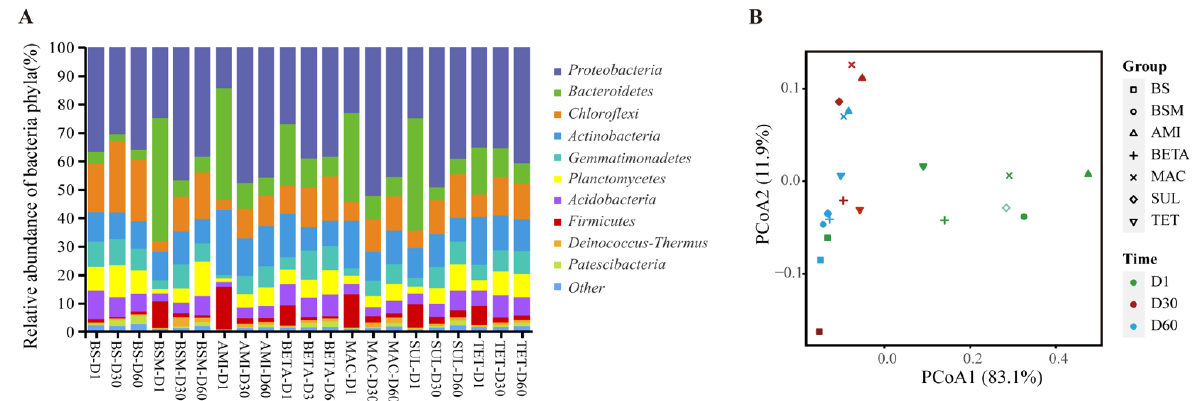
Figure 4. Bacterial abundance and diversity of different samples. ( A ) Relative abundance of major bacteria at the level of phylum. ( B ) PCoA plot of bacteria among different soil samples on day 1, 30, and 60.